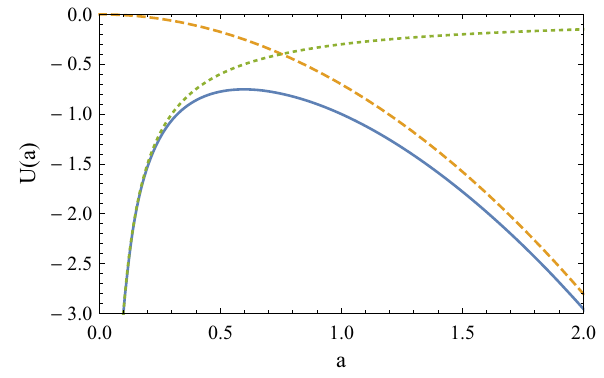
( 0 ) = 1, for the case of a flat (cid:3) ( 0 ) = 1, and m ( 0 ) = 0 . 7, (cid:2) ( 0 ) = 0 . 3, m (cid:3)